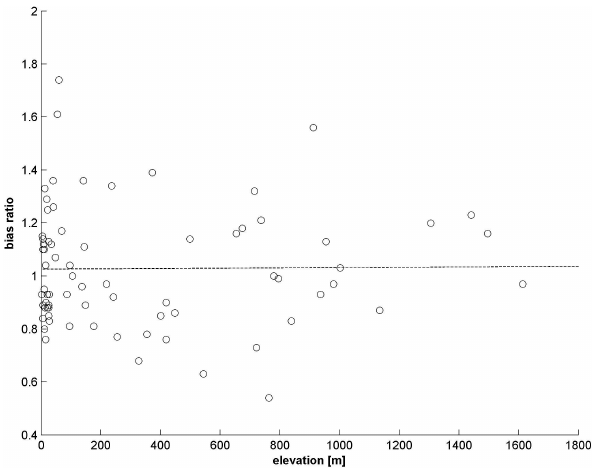
Fig. 10. Average monthly corrected TMPA 3B42RT data over 2003–2008, compared with ground station and uncorrected TMPA 3B42RT data for a TMPA grid cell in the Northern Territory (Darwin), Australia. Average annual precipitation 4 ground stations (Darwin airport, Karama, Leanyer and Shoal Bay)=1797mm, average annual uncorrected TMPA 3B42RT=1926mm and average annual bias corrected TMPA 3B42RT=1801mm. R 2 uncorrected TMPA 3B42RT=0.90; R 2 bias corrected TMPA 3B42RT=0.91; RMSE uncorrected TMPA 3B42RT=94.8mm per month; RMSE bias corrected TMPA 3B42RT = 85.6 mm per month.